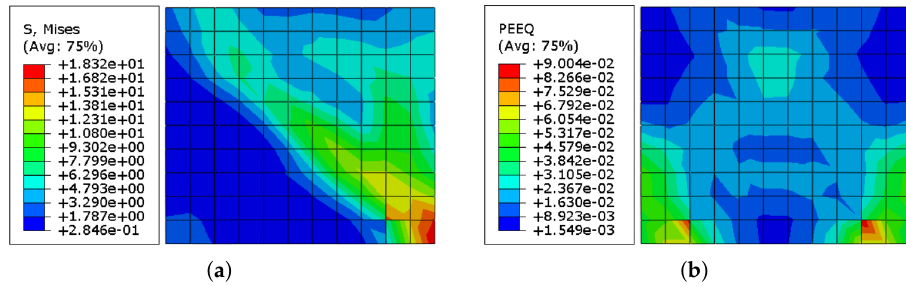
Figure 23. ( a ) Stress distribution in the ECC sheets used in the URM-SMA-ECC system; ( b )